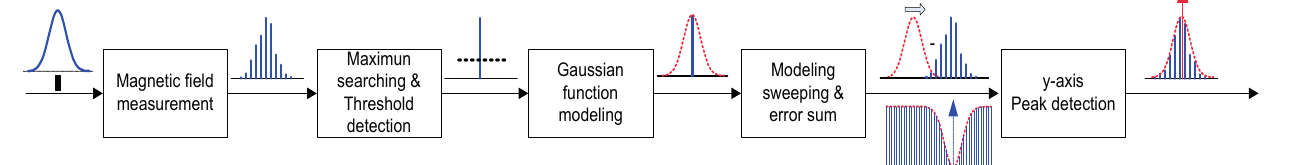
Figure 8. Signal processing flow chart for peak detection in the y axis (lateral direction of